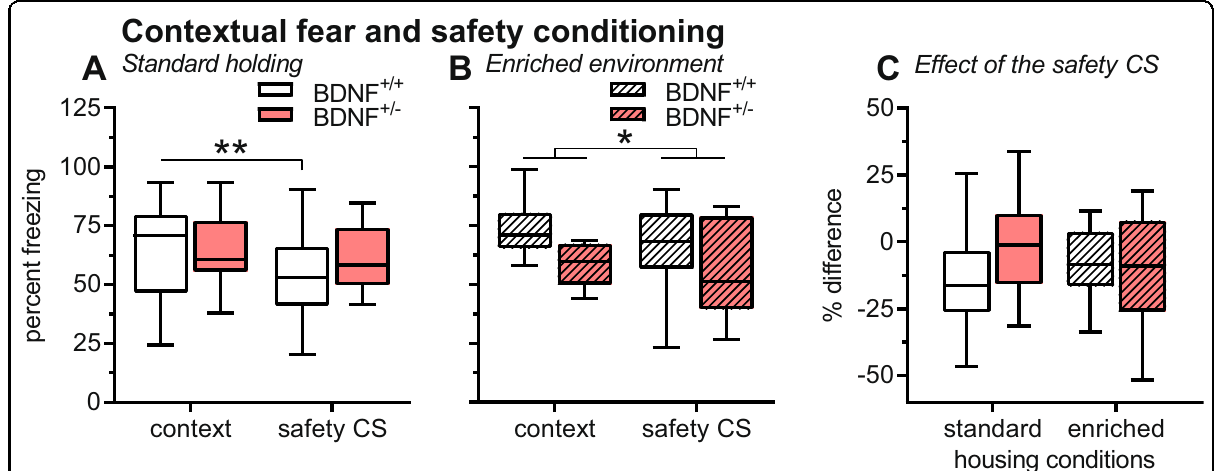
Fig. 4 Conditioned contextual fear was not affected by genotype but its reduction by a safety CS was impaired in BDNF + / − mice. This impairment was not observed after enriched environment. A , B Percent time spent freezing to the context and during presentations of the safety CS. A After standard housing, inhibition of freezing by the safety CS was observed in BDNF + / + but not BDNF + / − mice. B After enriched environment, both genotypes showed a reduction of freezing by the safety CS. C However, the analysis of the percent difference scores revealed neither an effect of genotype or housing condition nor an interaction. Group sizes: standard housing: 16 BDNF + / + mice, 17 BDNF + / − mice; enriched environment: 17 BDNF + / + mice, 8 BDNF + / − mice. ** P < 0.01, * P < 0.05, main effects in ANOVA ( B ) or post hoc comparisons as indicated ( A